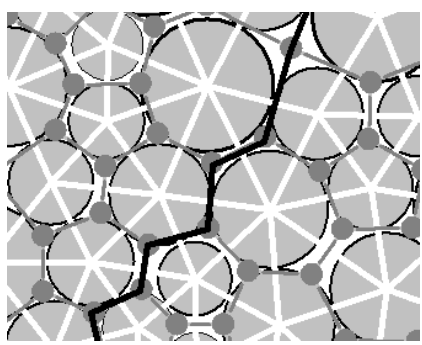
Figure 3. The particle-connection, the void cell and the particle contact in the aggregation of particles with different radius.